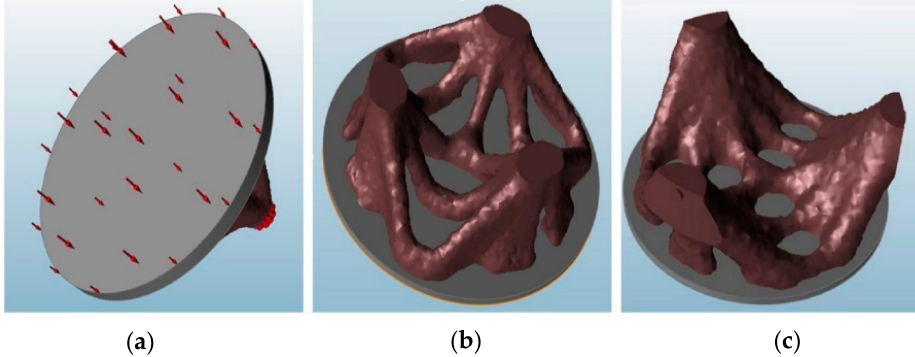
Figure 19. Applied loads and forces ( a ) to model top mount ( b ) and side mount ( c ) [30].